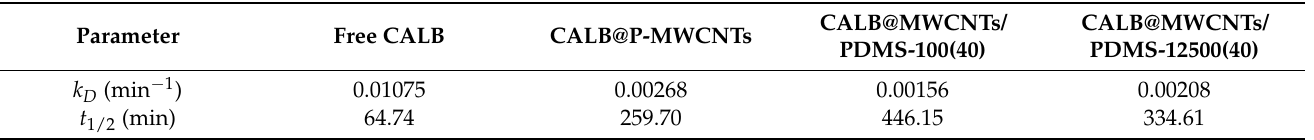
Table 2. Inactivation constant and half-life of free lipase and enzyme immobilized onto P-MWCNTs and MWCNTs/ PDMS nanocomposites.